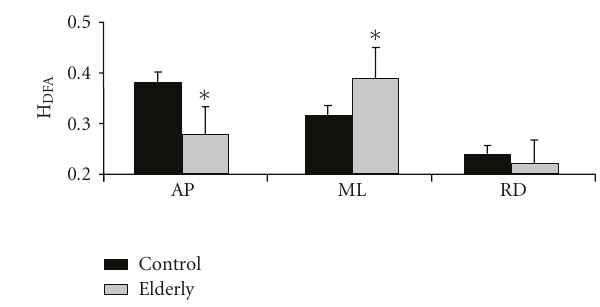
Figure 3: Estimation of the Hurst exponent using DFA for elderly and control subjects. Data are means and SD. ∗ denotes significant di ff erence from control